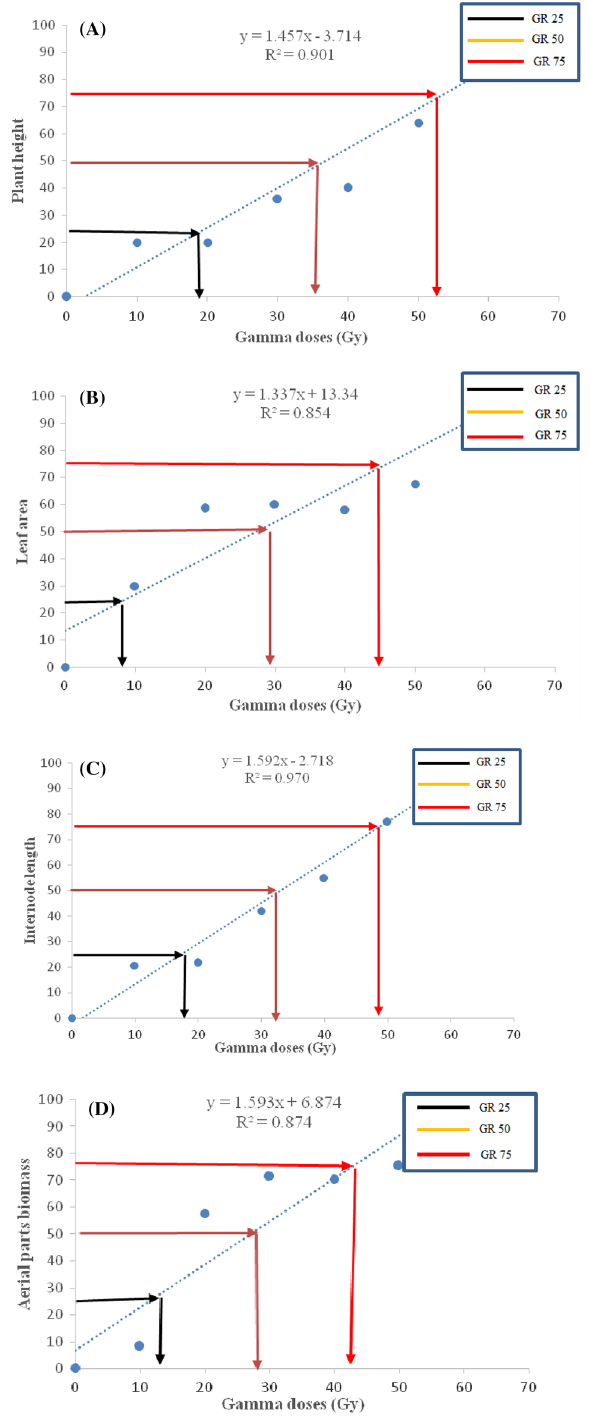
Figure 3. The effect of different gamma irradiation doses on growth reduction of shoot and leaves morphometric traits (plant height, panel A ; leaf area, panel B ; internode length, panel C , aerial part biomass, panel D ) of hardwood cutting of ‘Yaghouti’ grape ( Vitis vinifera L.)